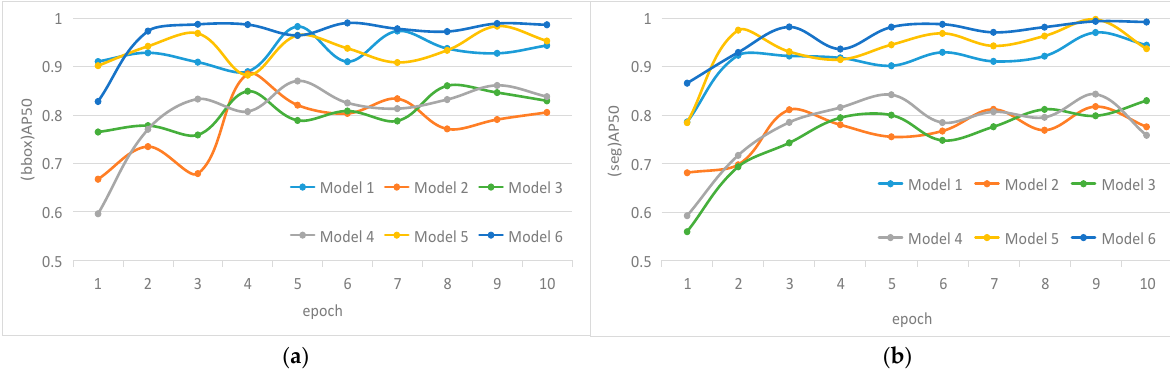
Figure 10. Change curve of evaluation index during training stage before and after Mask R-CNN optimization: ( a ) change curve of bbox AP50; ( b ) change curve of seg AP50.